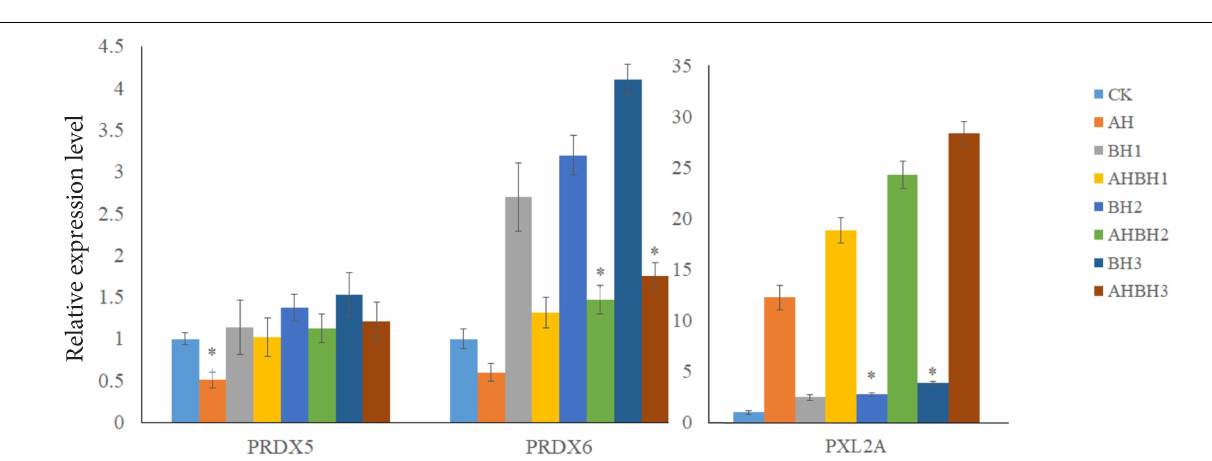
glutathione to complete 1-Cysprx activation (Manevich et